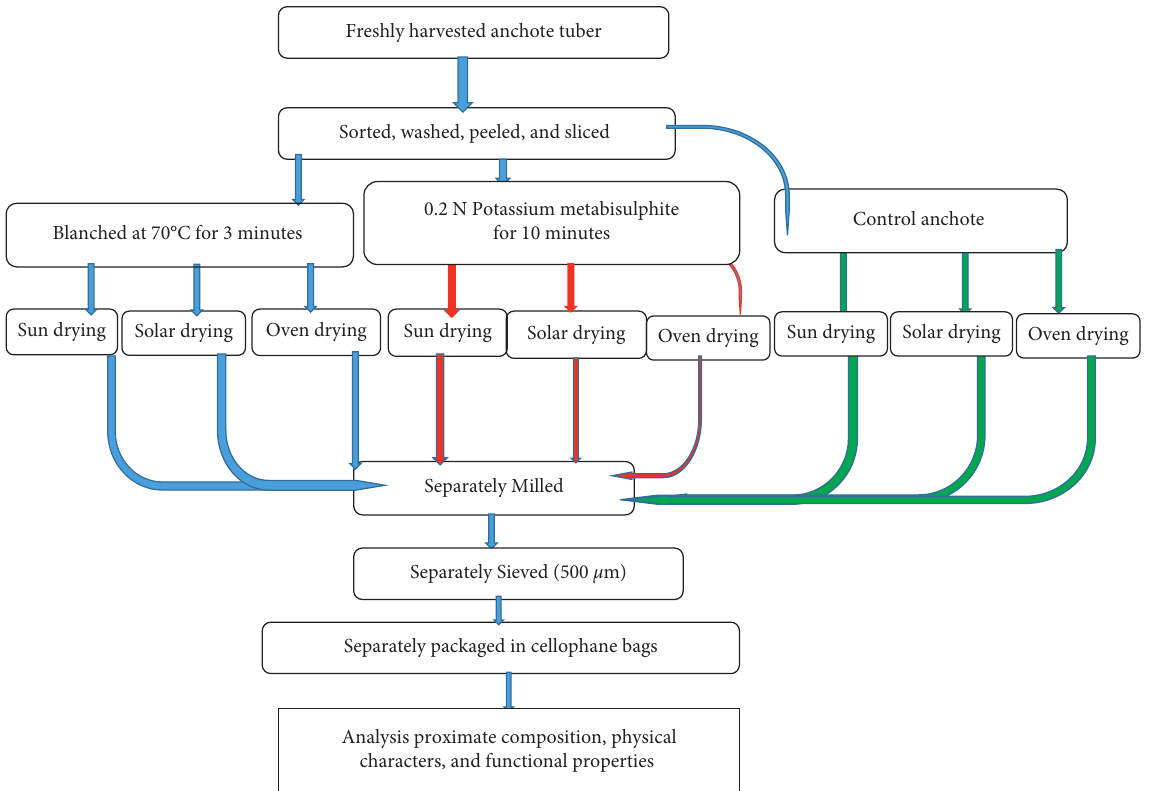
Figure 1: Anchote flour preparation and experimental design framework.